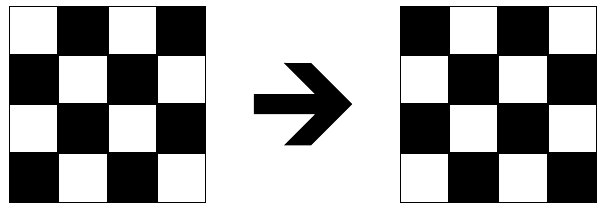
Figure 10. Monochrome inversion in a